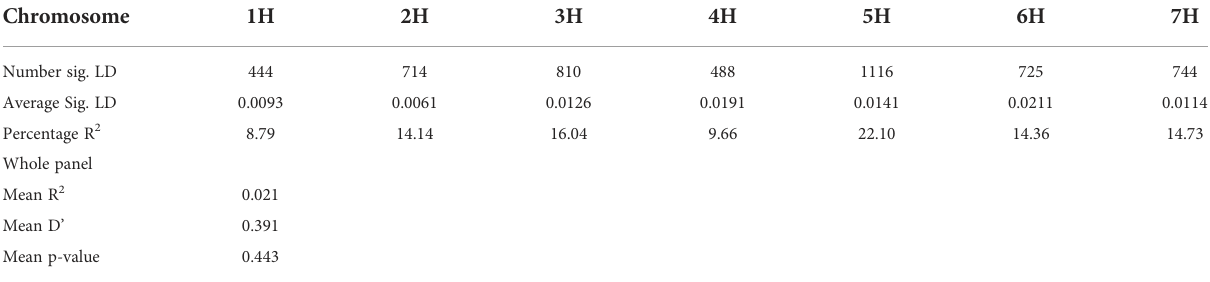
D ’ ; the standardized disequilibrium coef fi cient, R 2 ; represents the correlation between alleles at two loci, which is informative for evaluating the resolution of association